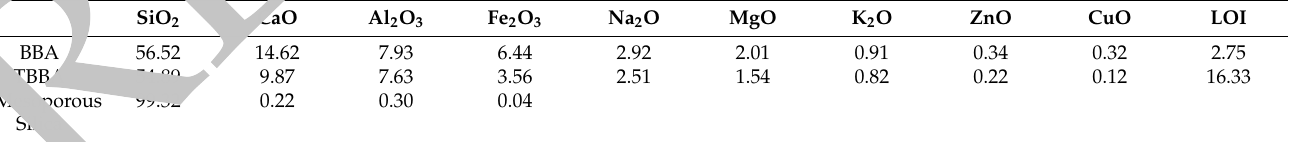
Table 1. Chemical composition of bagasse bottom ash (BBA), acid-treated bagasse bottom ash (TBBA), and obtained silica in wt%. SiO